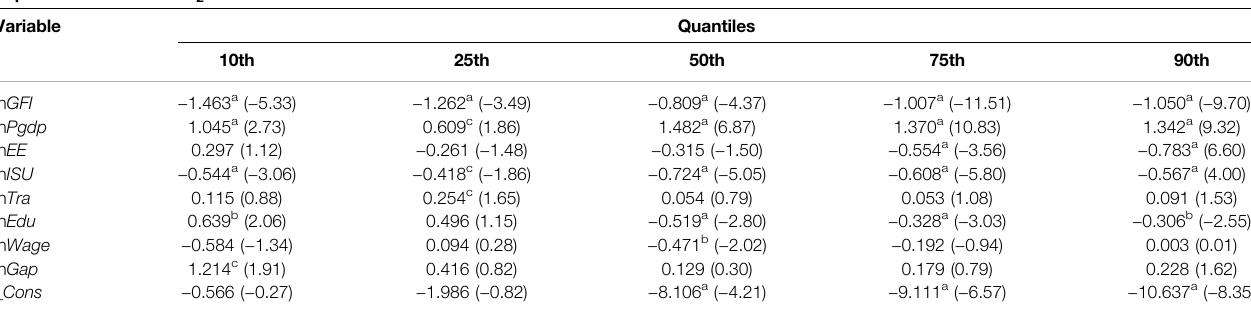
TABLE 6 | Estimated results of the heterogeneity of CO 2 emissions.